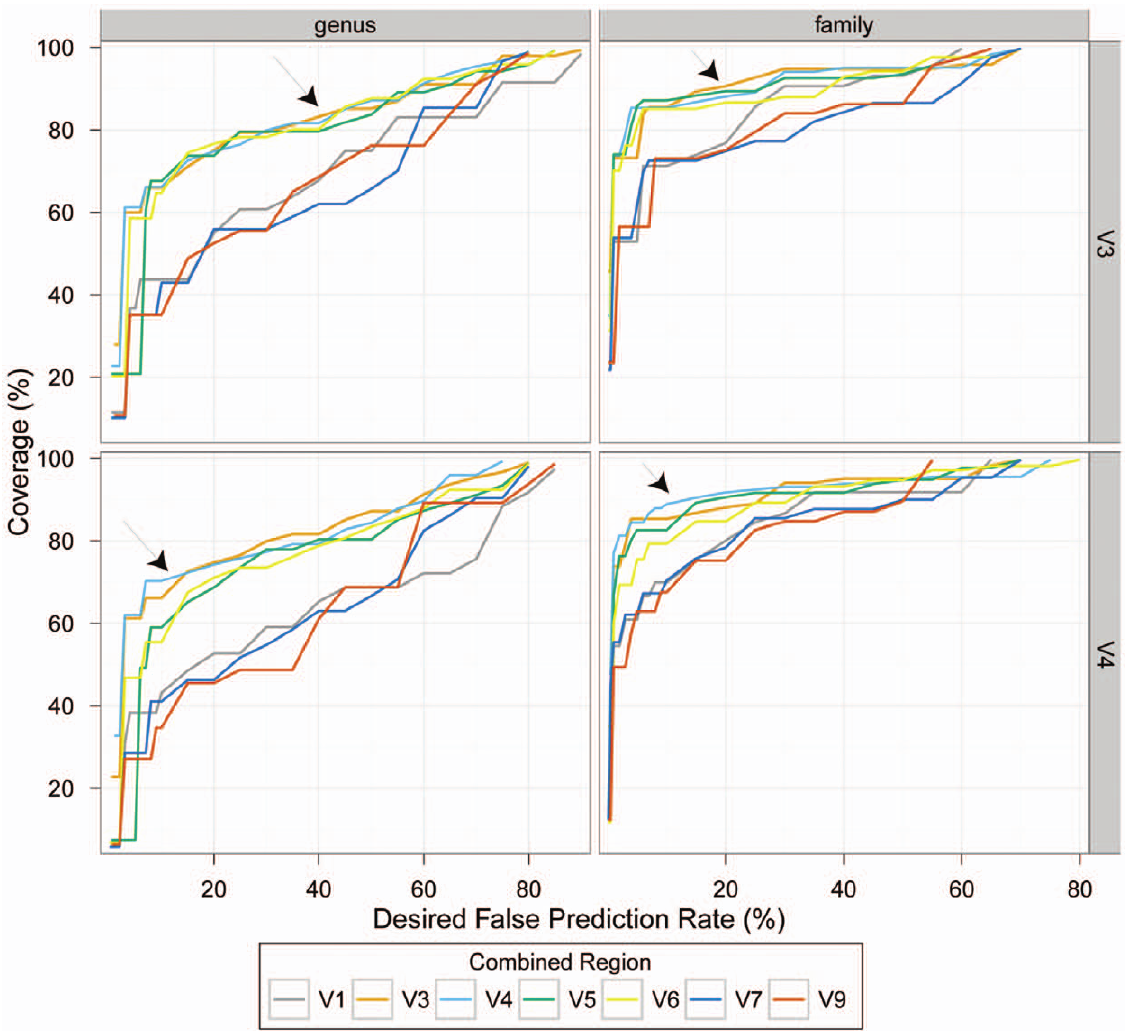
Figure 3. Classification performance of combined 100 nt single-read predictions, as compared to the best performing paired-end configurations. We combined predictions made for different 100 nt fragments of the same sequence, by selecting the prediction with the highest confidence score at the genus level (or the lowest common level available). We evaluated the performance, at ranks genus and family (left and right panels, respectively), of combinations of fragments from the V3 and V4 regions (top and bottom panels, respectively) with fragments from each of the other regions examined, and compared it to the performance of the V3 and V4 100 nt paired-end configurations (pointed to by arrows). We used the results of leave-k-out tests classifying the LTP sequences to determine confidence score thresholds for a set of desired false prediction rate (FPR) values (x axis), so that the FPR would be at most the desired value. We then used these thresholds to calculate the classification coverage of sequences from environmental (uncultured) bacteria that corresponds to the desired FPR (y axis). Figure S6 compares the performance of the combinations for the ranks order, class, and phylum.